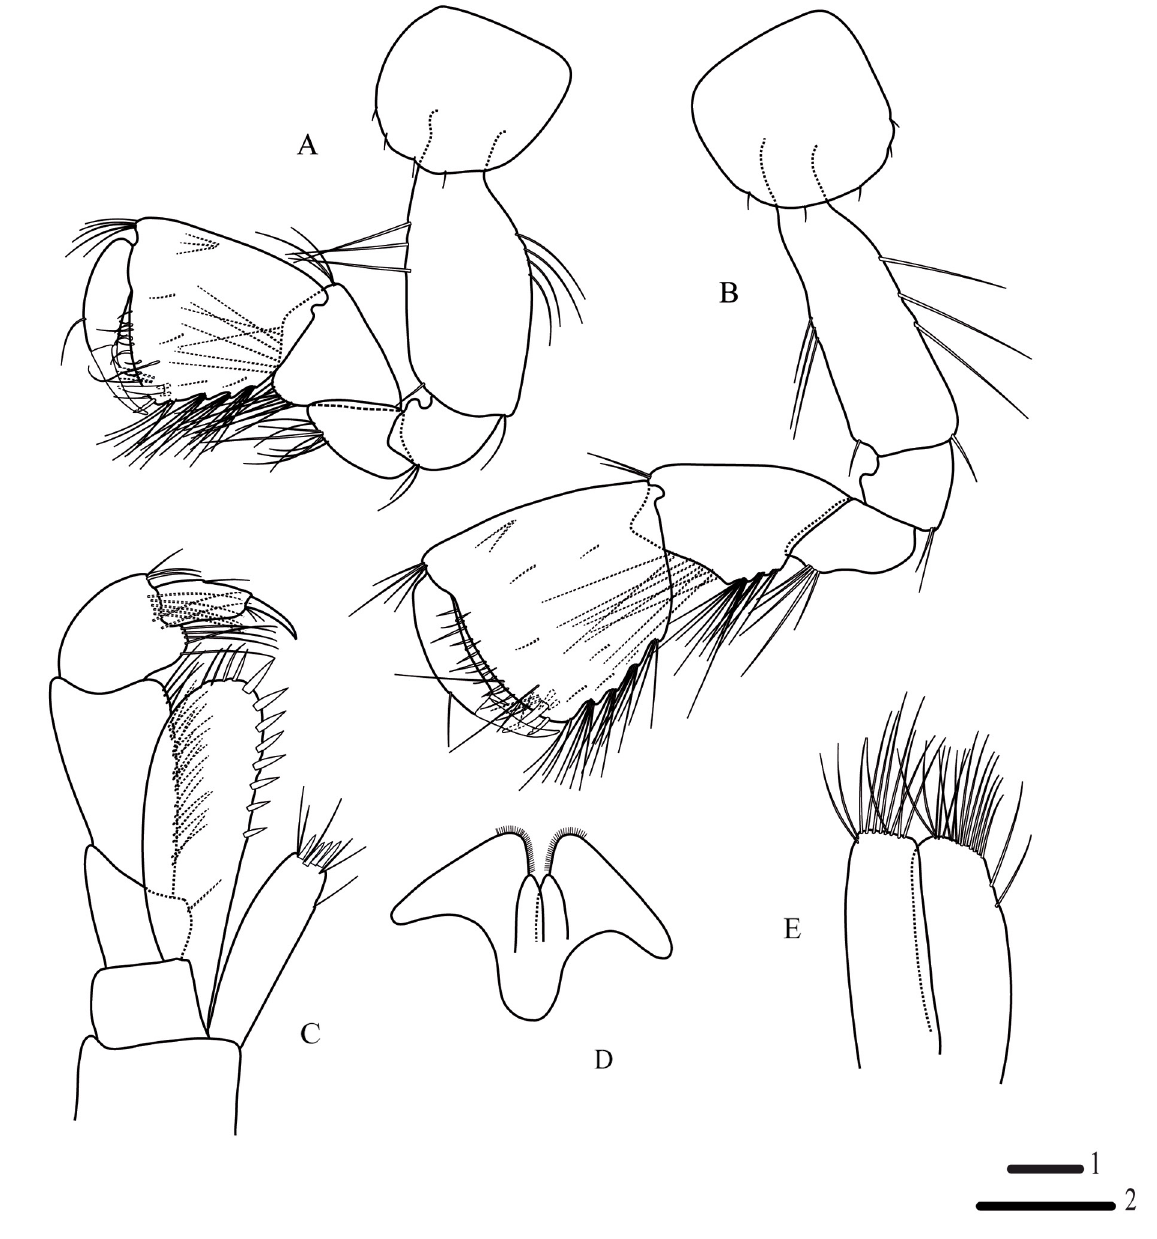
Fig. 8. Niphargus fiseri sp. nov., holotype, ♂, 8 mm (ZCRU Amph.1073). A . Gnathopod I. B . Gnathopod II. C . Maxilliped. D . Labium. E . Maxilla II. Scale bars: 1 = 0.5 mm (C–E); 2 = 1 mm